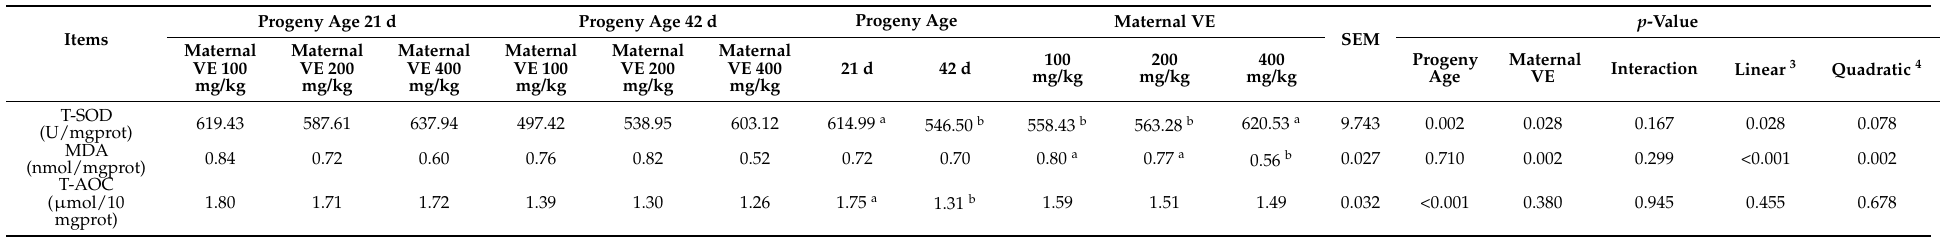
Table 6. Effects of maternal dietary vitamin E supplementation and progeny age on the liver antioxidant status of offspring hatched from stored eggs (trial 2) 1,2 .